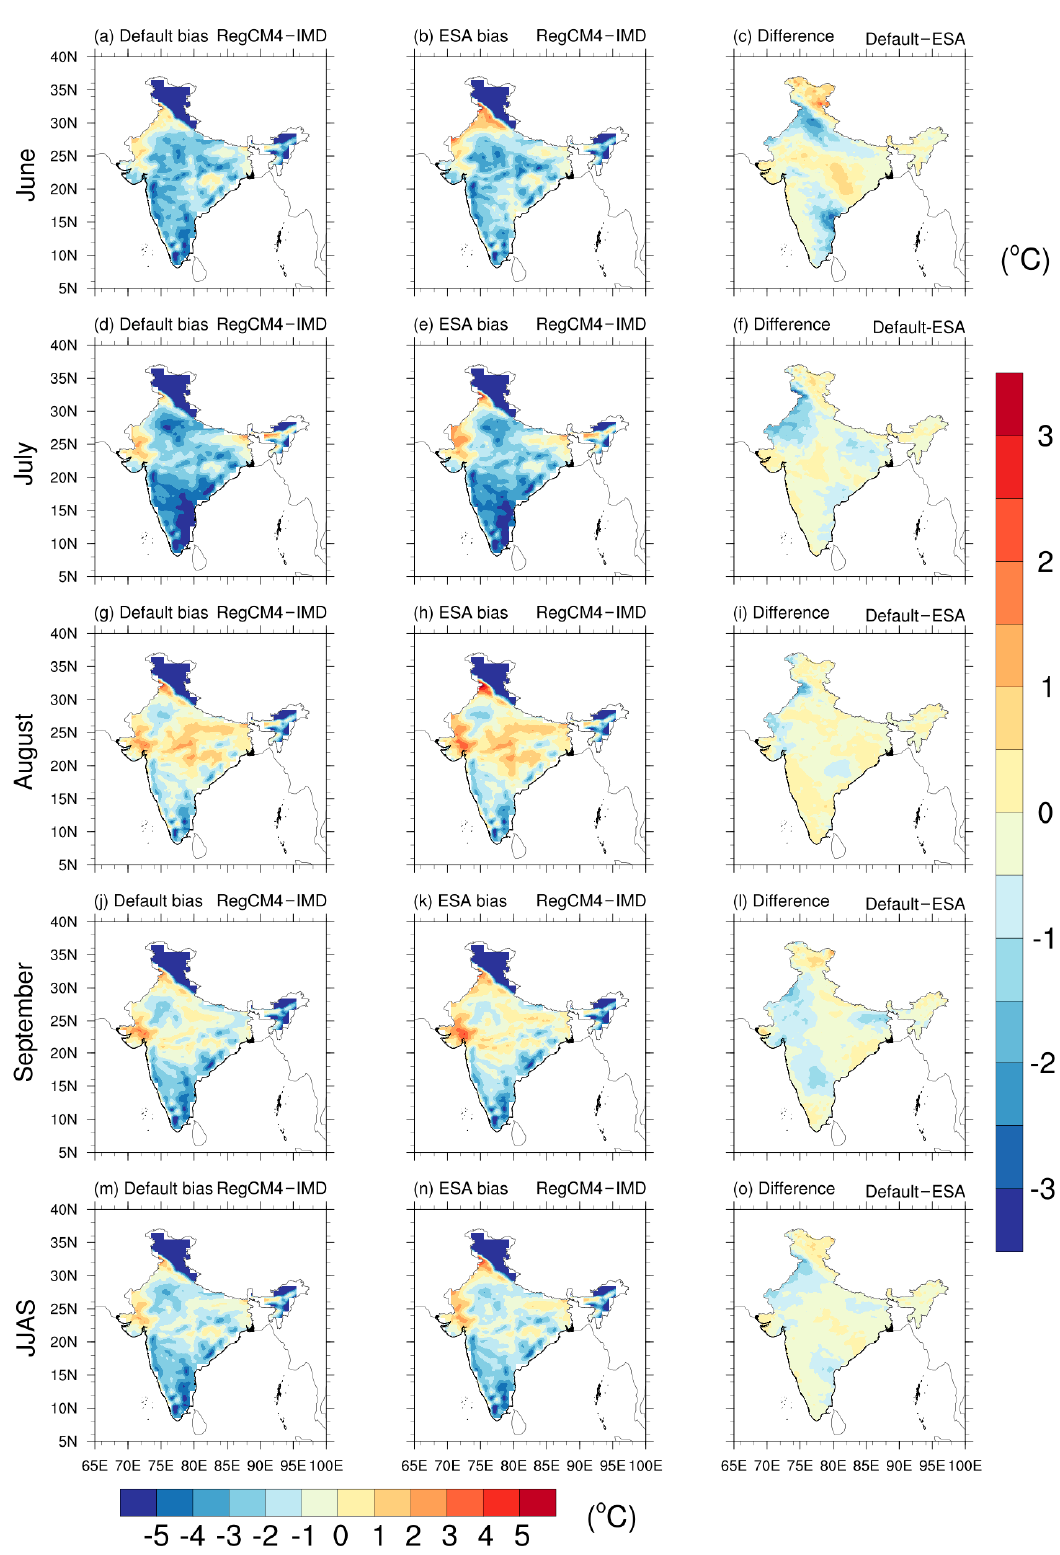
Figure 2. Surface temperature bias (°C) at monthly and seasonal scales for the year 2002 from both the model configurations. IMD analysis is considered as ground truth. Rows correspond to ( a – c ) June, ( d – f ) July, ( g – i ) August, ( j – l ) September and ( m – o ) JJAS means. Columns represent the results from the default setup (1st column), ESA setup (2nd column) and their difference (3rd column).